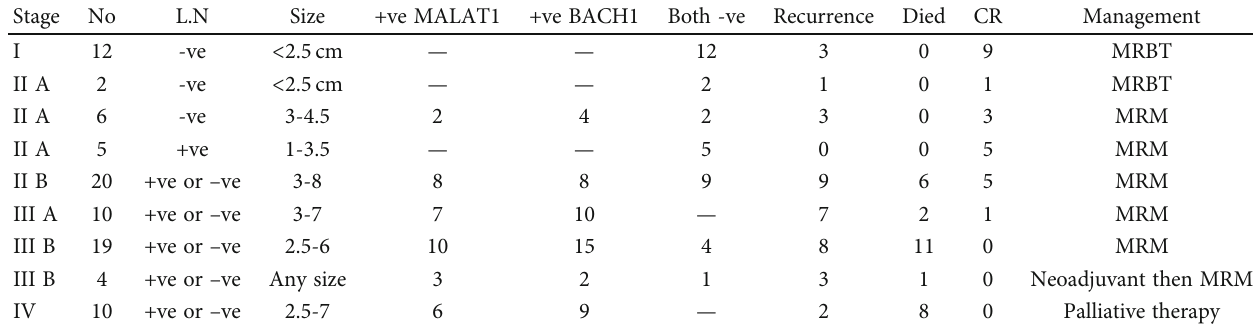
Table 9: Summary of surgical management of our